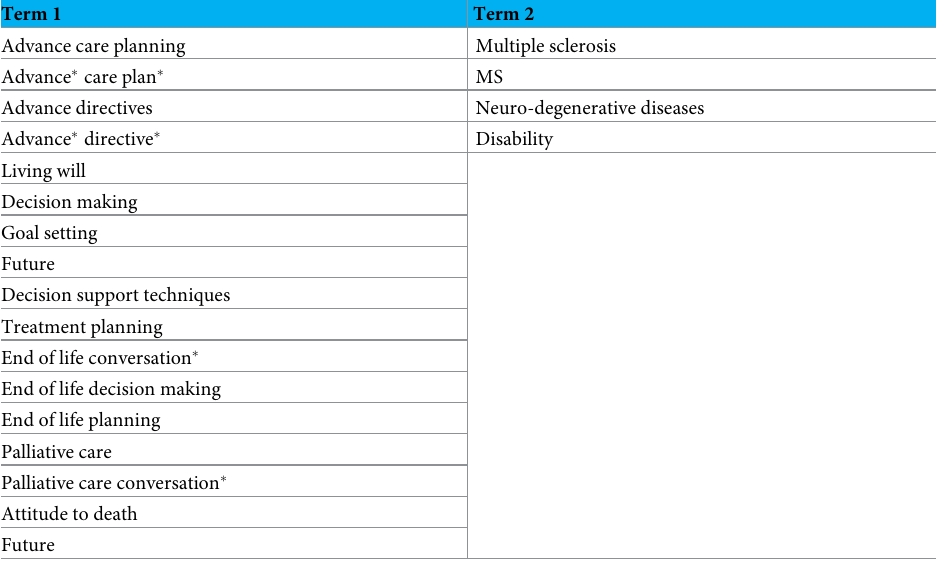
Table 3. Search strategy for MEDLINE, PsychInfo, CINAHL, Scopus, Web of Science, and